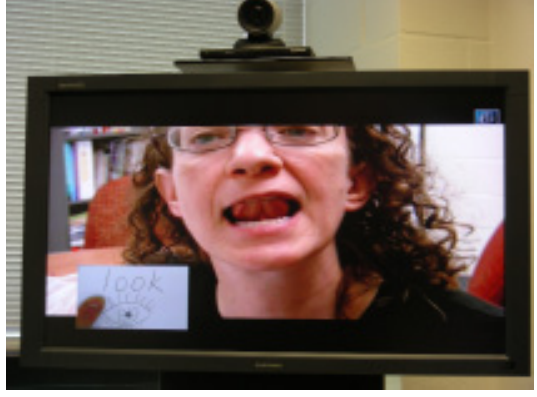
Figure 4. Large image of SLP with document camera image as